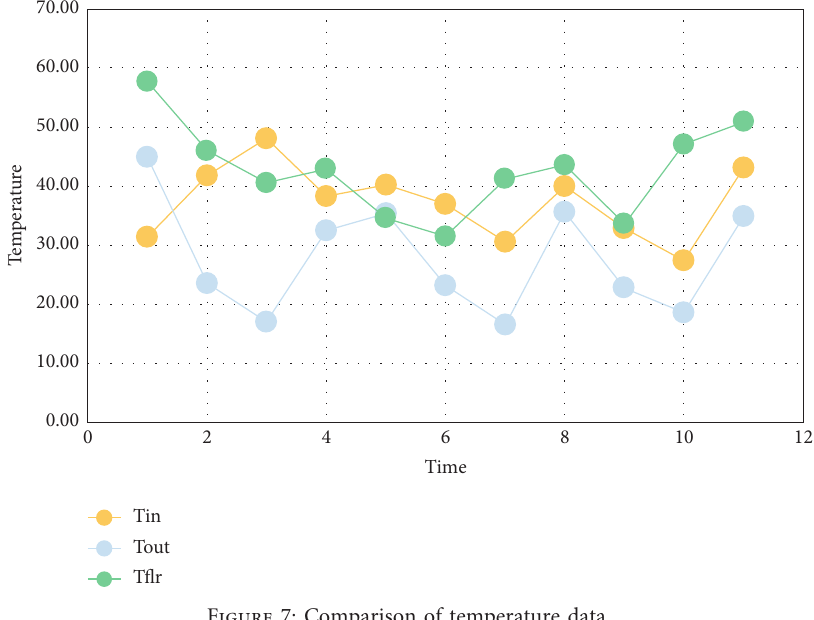
Figure 7: Comparison of temperature data.